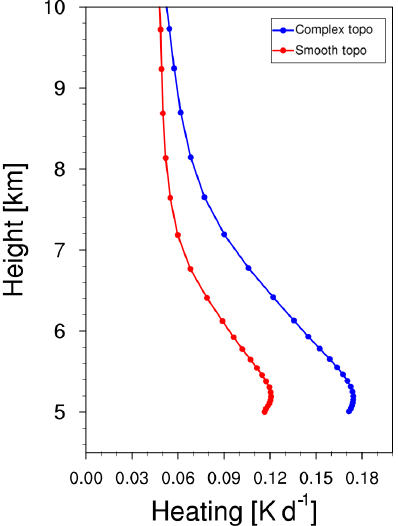
Figure 15. Vertical profiles of BC-induced radiative-heating rate in the atmosphere averaged over the TP (with elevation > 4km) from the simulations with the complex and smooth topographies during 1–20 April